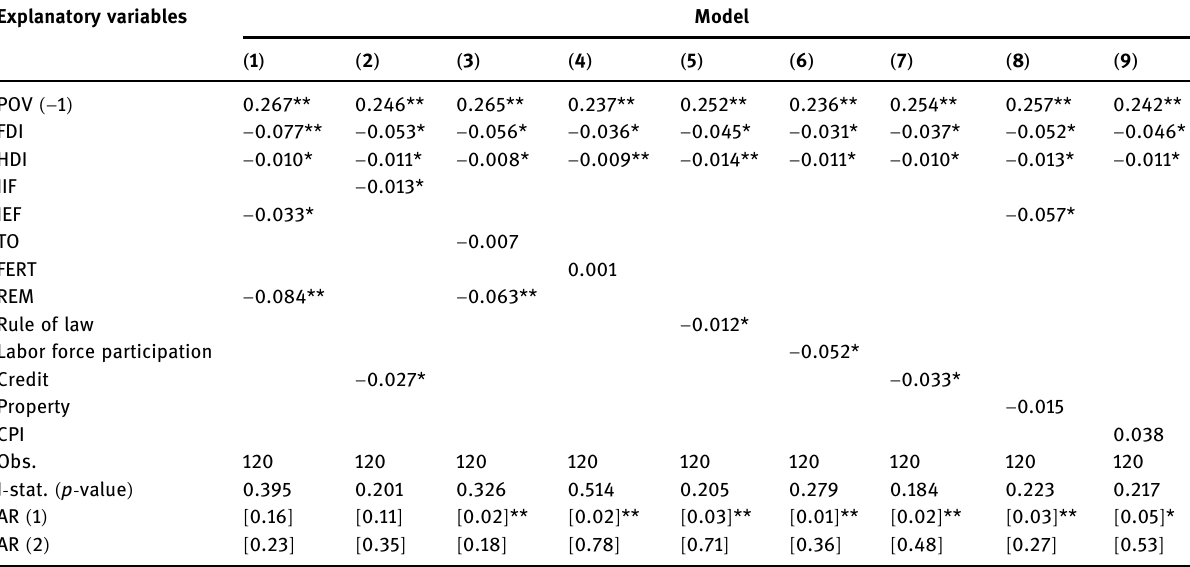
Table 4: GMM estimation results, where the dependent variable is poverty headcount ratio Explanatory